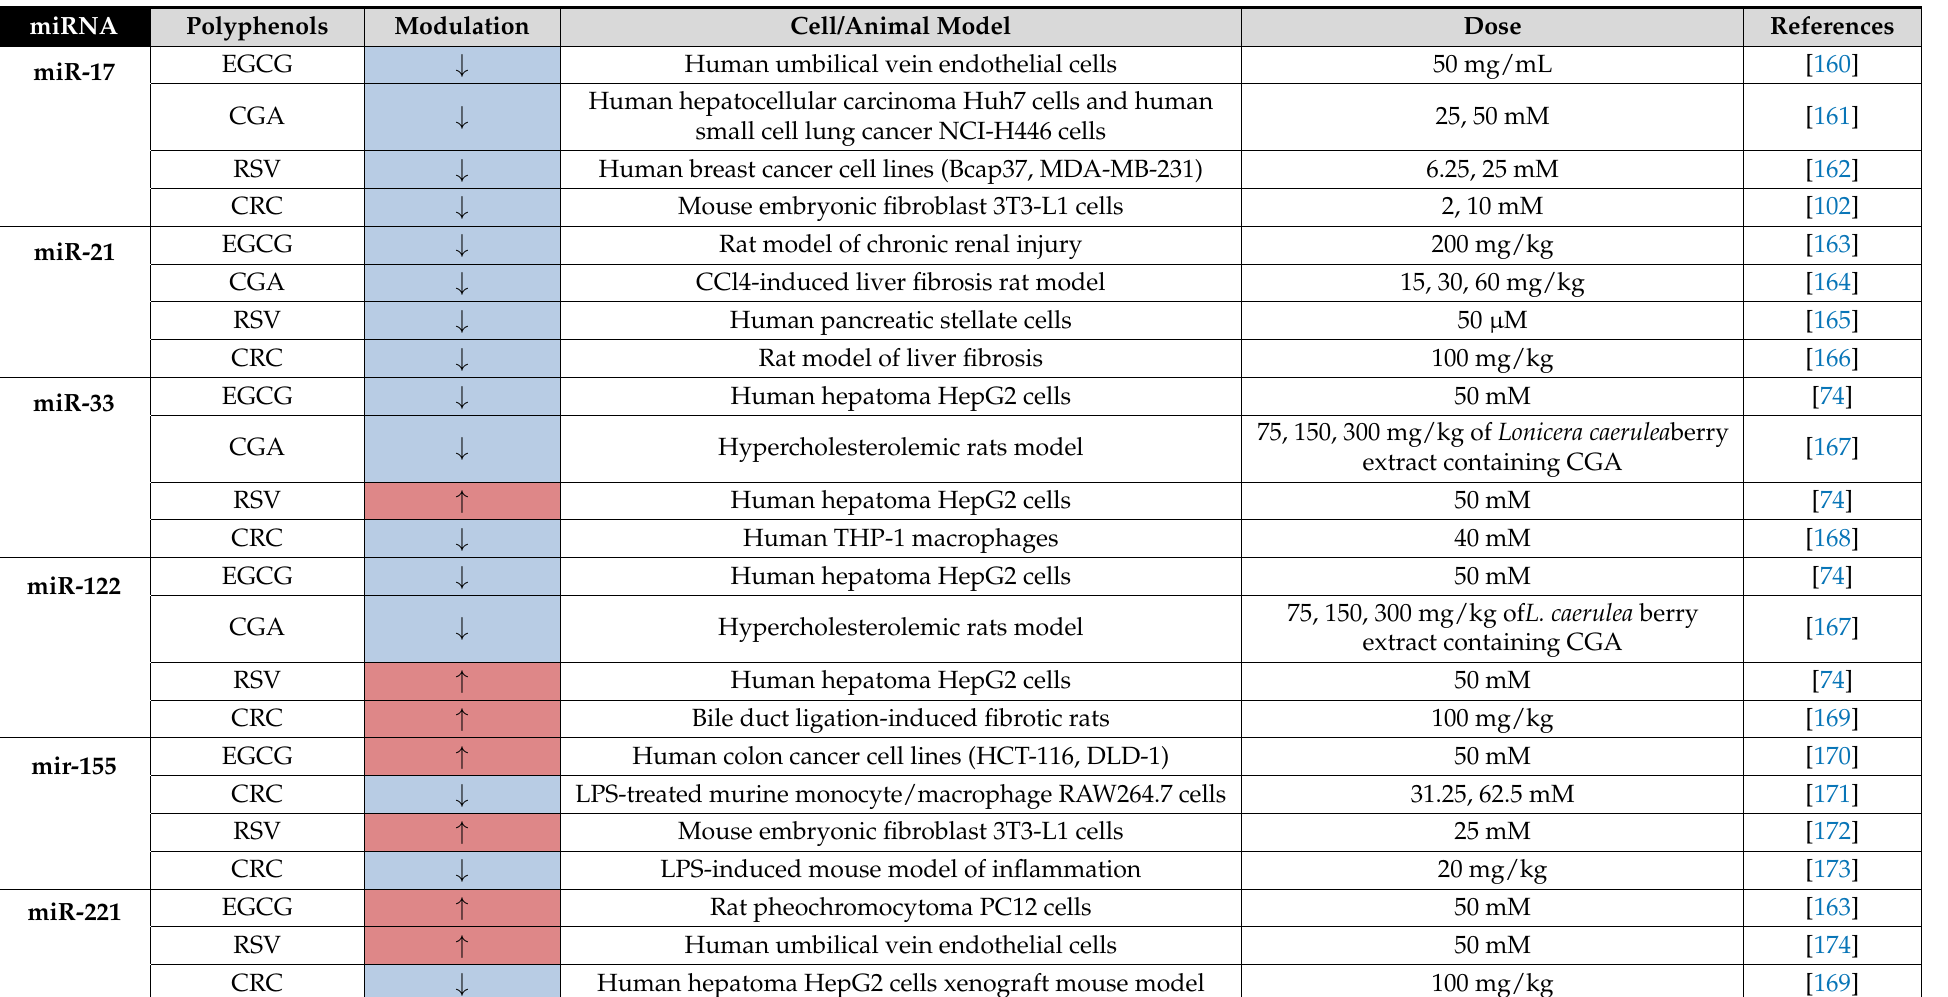
Table 2. MiRNA modulation by EGCG, CGA, RSV, and CRC polyphenols. Arrows in red boxes ( ↑ ) and blue boxes ( ↓ ) represent upregulation and downregulation,